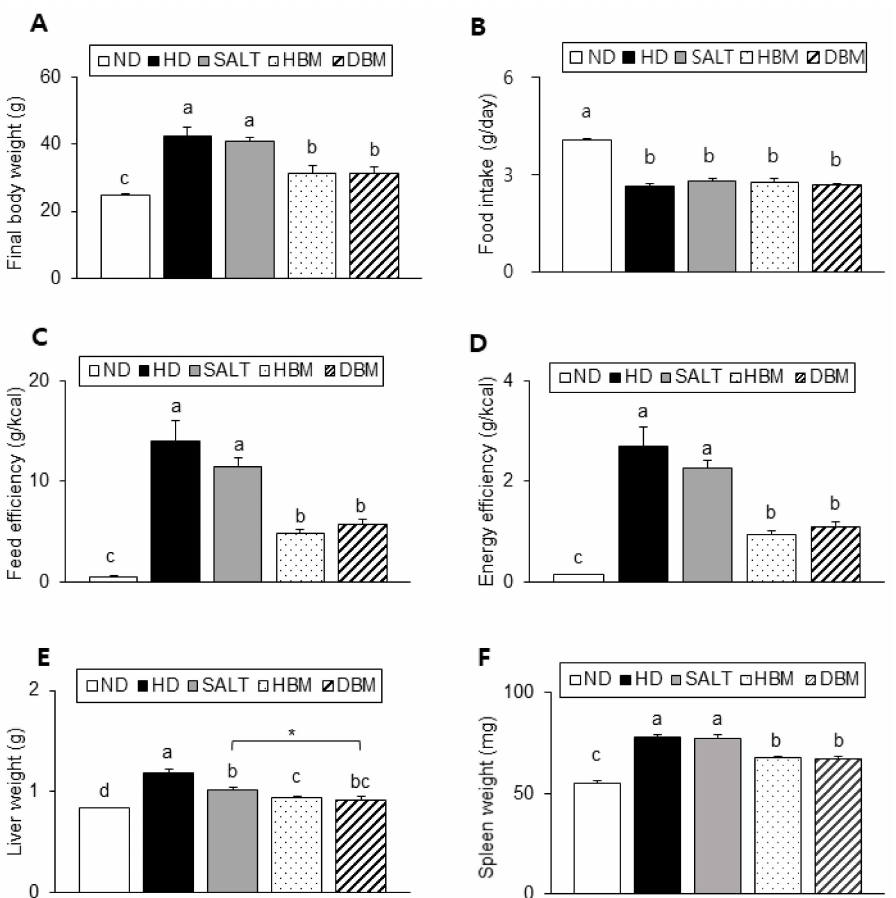
Figure 2. Effects of Gochujang on body and organs weight in the HD-fed mice. ( A ) Final body weight of mice; ( B ) Food intake; ( C ) Feed efficiency; ( D ) Energy efficiency; ( E ) Liver weight; ( F ) Spleen weight. Values are mean ± SEM. a–d means with the different letters on the bar ( p < 0.05). (a > b > c > d). * p < 0.05. ND, normal diet group; HD, high-fat diet group; SALT, HD with 0.7% salt group; HBM, HD with 10% of HBM Gochujang group; DBM, HD with 10% of DBM Gochujang